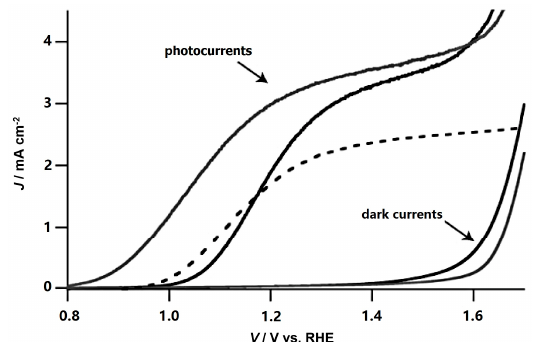
Figure 9. Performance of the unmodified hematite photoanode (solid black trace), and the same anode that was functionalized with IrO 2 nanoparticles (solid gray trace). Conditions: 1 M NaOH solution (pH 13.6), 10 mV/s scan rate, uncorrected for Ohmic losses. The corresponding dark currents are also shown. The dashed trace is the photocurrent for the former state-of-the-art hematite photoanode. Adapted with permission from [31]. Copyright 2010 John Wiley & Sons.